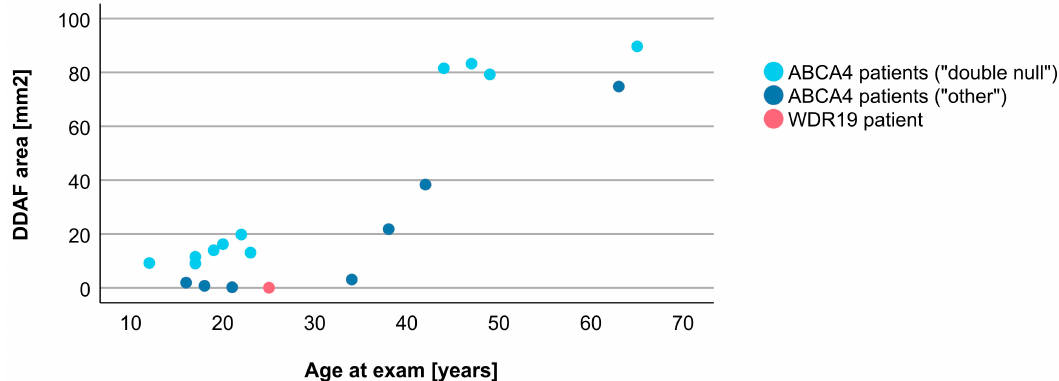
Figure 6. Comparison of DDAF area, representing retinal pigment epithelium (RPE) atrophy, between WDR19 patient (red), double null ABCA4 patients (light blue) and ABCA4 patients with other genotypes (dark blue). For this analysis a limited number of “other” ABCA4 patients (only those harboring ABCA4 variant c.5714+5G>A (p.[=,Glu1863Leufs*33]) was included (see Materials and Methods).